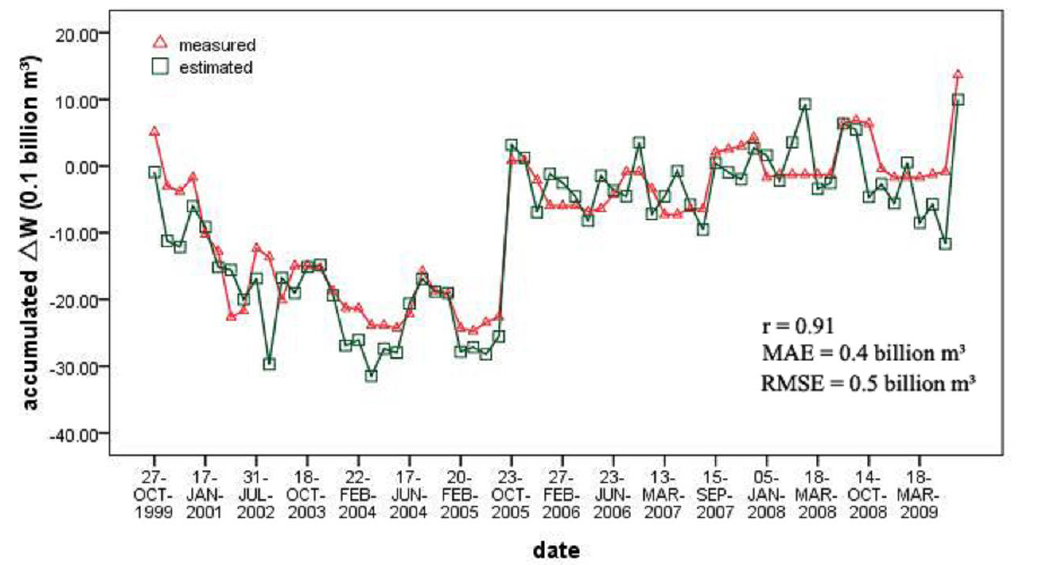
Figure 10. Time series of the estimated accumulated water volume variations versus measurements. The green square represents the accumulated water volume variations estimated by our